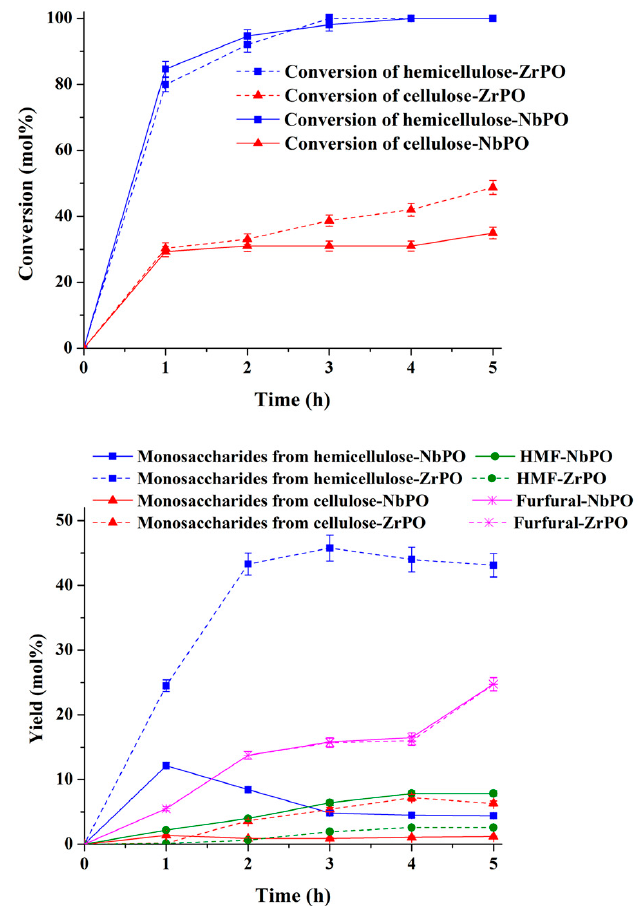
Figure 10. Catalytic performances of NbPO and ZrPO in the conversion of conifer wood sawdust at 150 °C. Reaction conditions: biomass = 2.68 g catalysts = 2.23 g water = 51.0 g T = 150 °C, autogenic pressure. As reported in the Materials and Methods, yields have been calculated with respect to the amount of cellulose or hemicellulose present in the starting biomass. Note: where the error bars are not visible, they are smaller than the symbols.